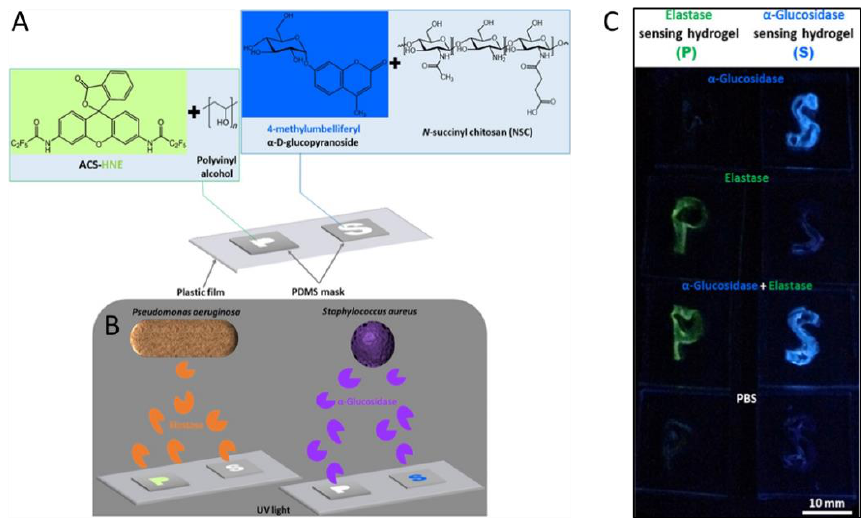
Figure 3. Schematics of the shape-encoded hydrogel sensors for detection and differentiation of P. aeruginosa and S. aureus ( A , B ). ( A ) Chemical structures of fluorogenic substrates and hydrogel matrices. ( B ) Fluorescence output in the form of the shape-encoded letters P (green) and S (blue) is defined by the corresponding target enzymes secreted from P. aeruginosa and S. aureus. ( C ) Photograph of the shape-encoded enzyme-sensing hydrogels after enzymatic reactions. The photo was taken after a reaction time of 60 min under UV illumination (hand-held lamp, λ ex = 365 nm) on a black background ([MUD] = 1 mM, [ACS-HNE] = 5 µ M). Individual enzyme solutions, [ α -glucosidase] = 1.0 µ M and [elastase] = 10 µ M, were added in the first and second row, respectively. A mixed enzyme solution ([ α -glucosidase] = 2.0 µ M, [elastase] = 20 µ M with a volume ratio of 1:1) (Reprinted and adapted with permission from [45]. Copyright 2022 American Chemical